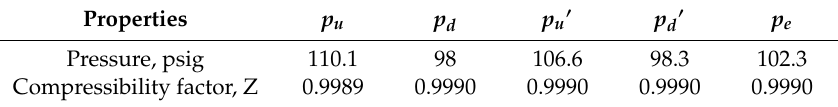
Table 2. Pressure and compressibility factor of data points in Figure